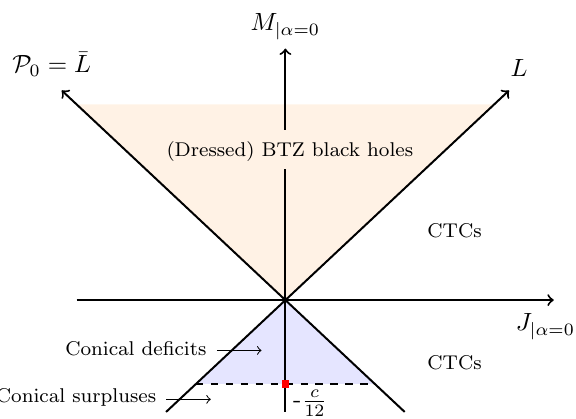
Figure 5. With the exception of the vacuum, states with imaginary U(1) charge in the WCFT correspond to pathological solutions with (cid:22) L < 0 in the bulk